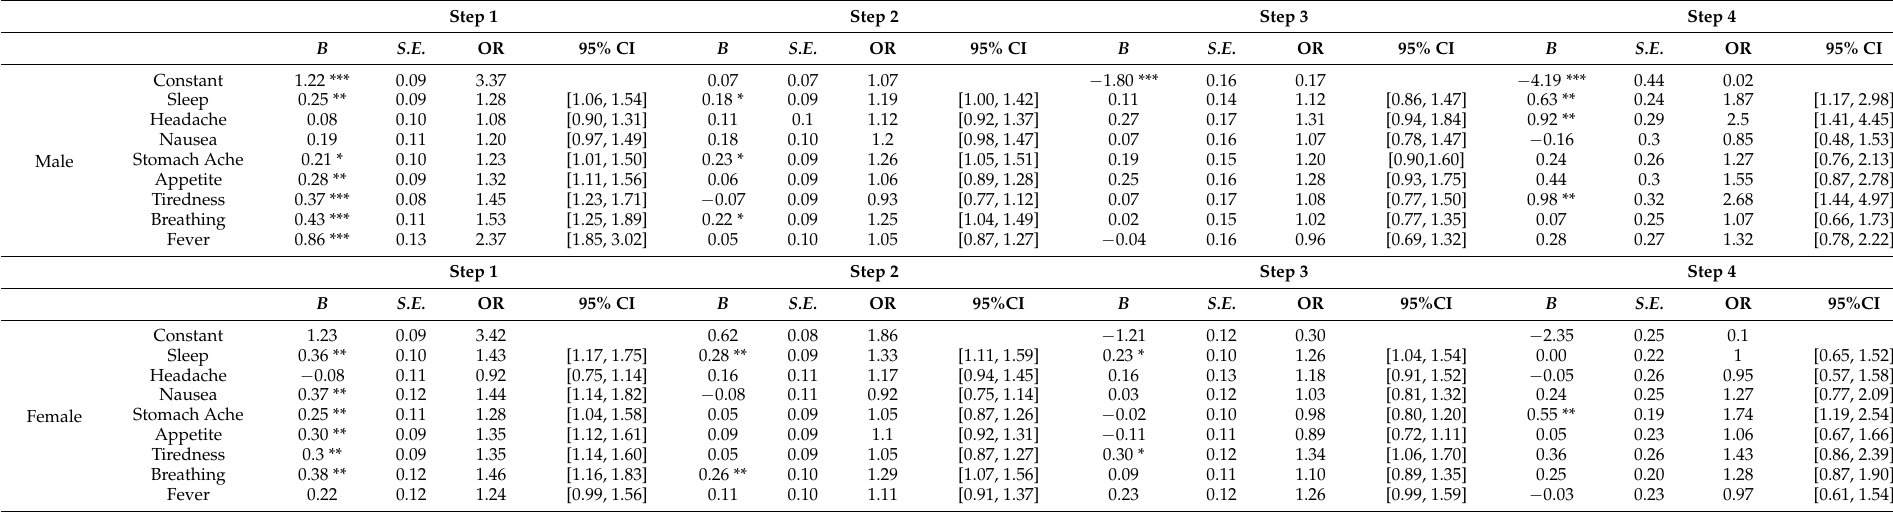
Table 2. Logistic regression with somatic